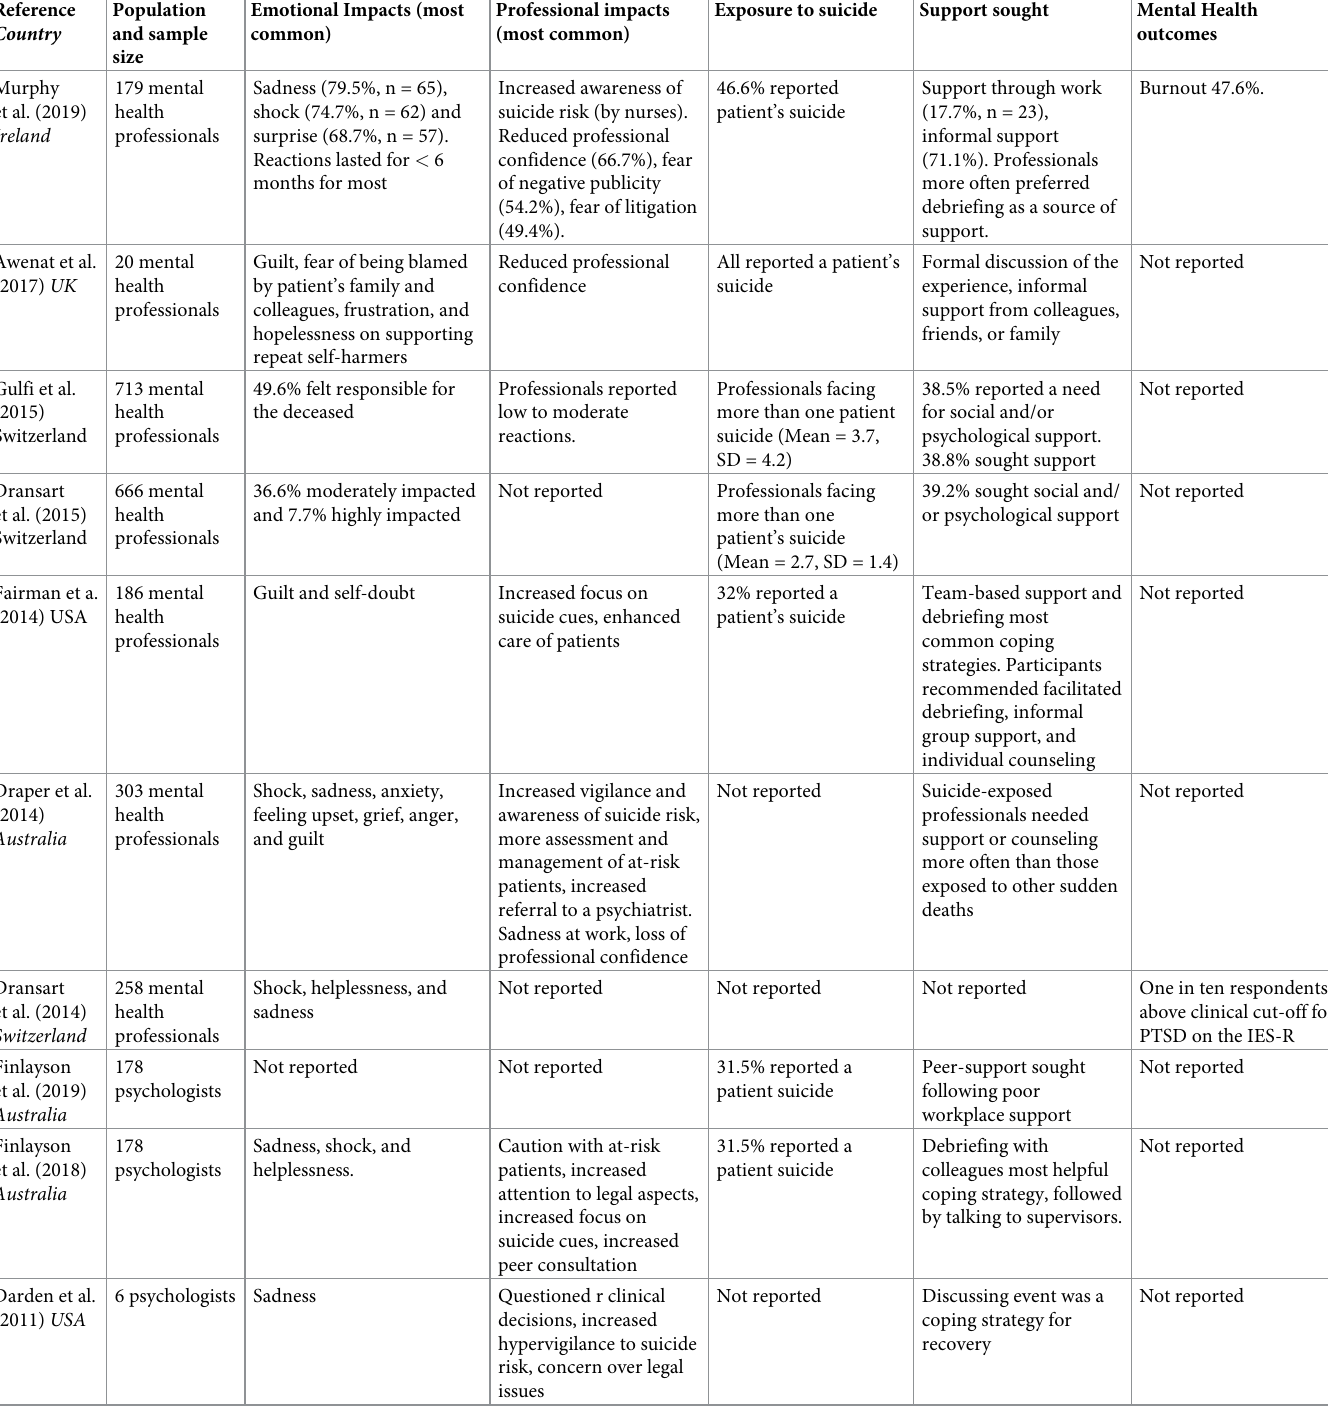
Table 1. Literature review